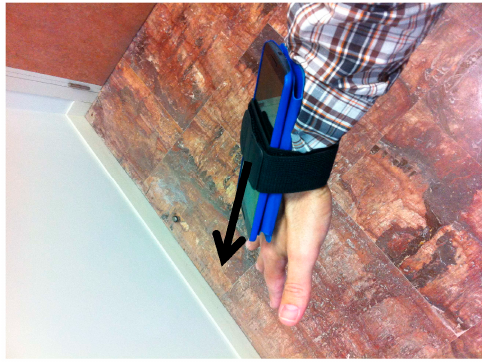
Figure 3. Data gathering system.